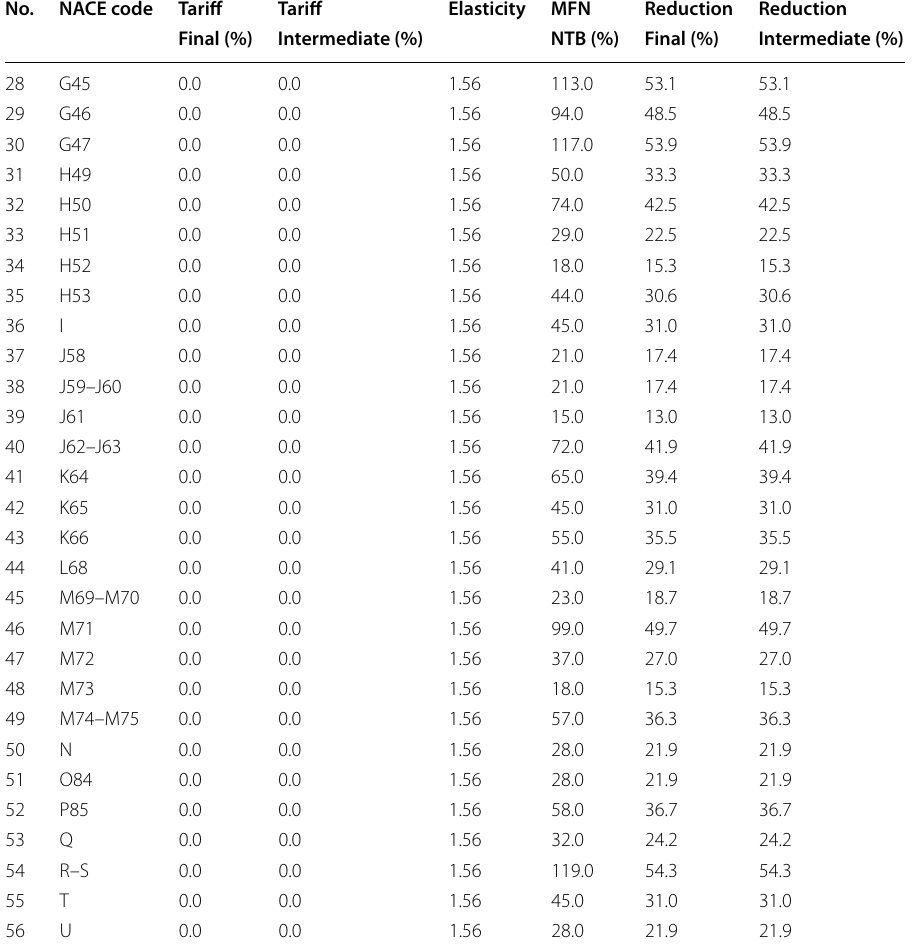
Table 9 Industry‑specific tariffs, elasticities, non‑tariff trade barriers, and reductions in trade volumes